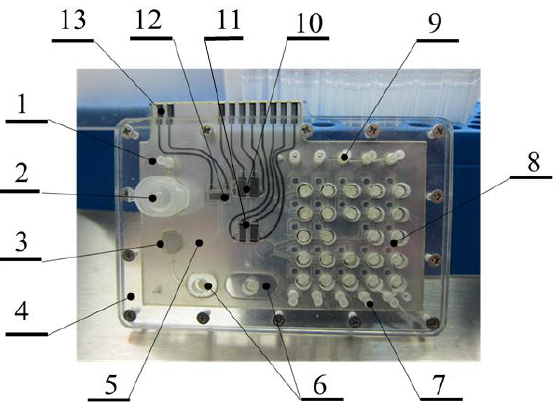
Figure 1. A sample model of lab-on-a-chip for total microbiological analysis. 1—pump inlet; 2—schwab inlet well; 3—growth chamber; 4—case; 5—CCD image capture area; 6—waste basins; 7, 9—antibiotic injection sleeves; 8—bacteria viability testing cells (two series of 10 cells); 10—impedimetric sensor; 11—SAW keys; 12—acoustic sensor; and 13—contact pads [9].